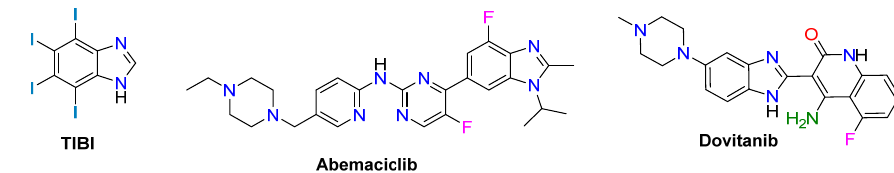
Figure 10. Selected examples of antitumor.